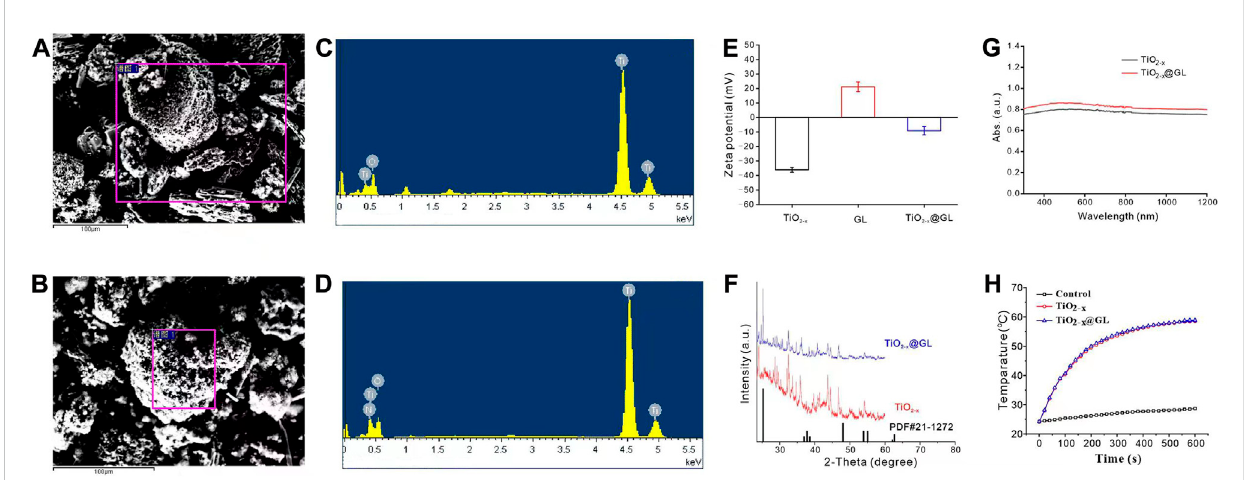
FIGURE 2 Characteristics of TiO 2-x NPs and TiO 2-x @GL NPs (A, B) SEM images of TiO 2-x NPs (B) ; and TiO 2-x @GL NPs (C, C, D) EDS of TiO 2 -x NPs (C) obtained basedonthepurplerectangleareain (A) ;andTiO